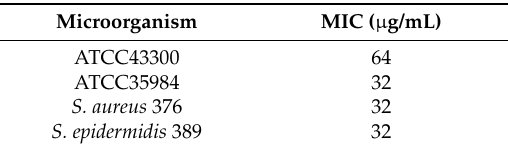
Table 2. The MICs of the four tested strains.